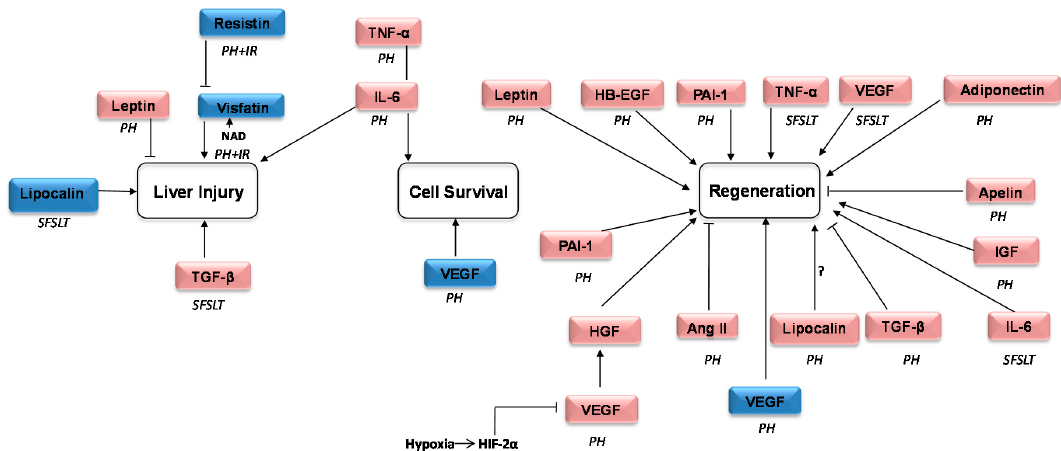
Figure 1. Schematic representation of the currently explored adipokines reported as involved in regeneration and/or liver injury in surgical procedures requiring liver regeneration and vascular occlusion in the last five years. Pink: adipokines in non-steatotic liver surgery. Blue: adipokines in steatotic liver surgery. The symbol ? means that controversial results have been reported. ↑ Promotion or activation of the process. ┤ Inhibition or decrease of the process. PH: partial hepatectomy; I/R: ischemic reperfusion; SFSLT: liver resection and small-for-size liver